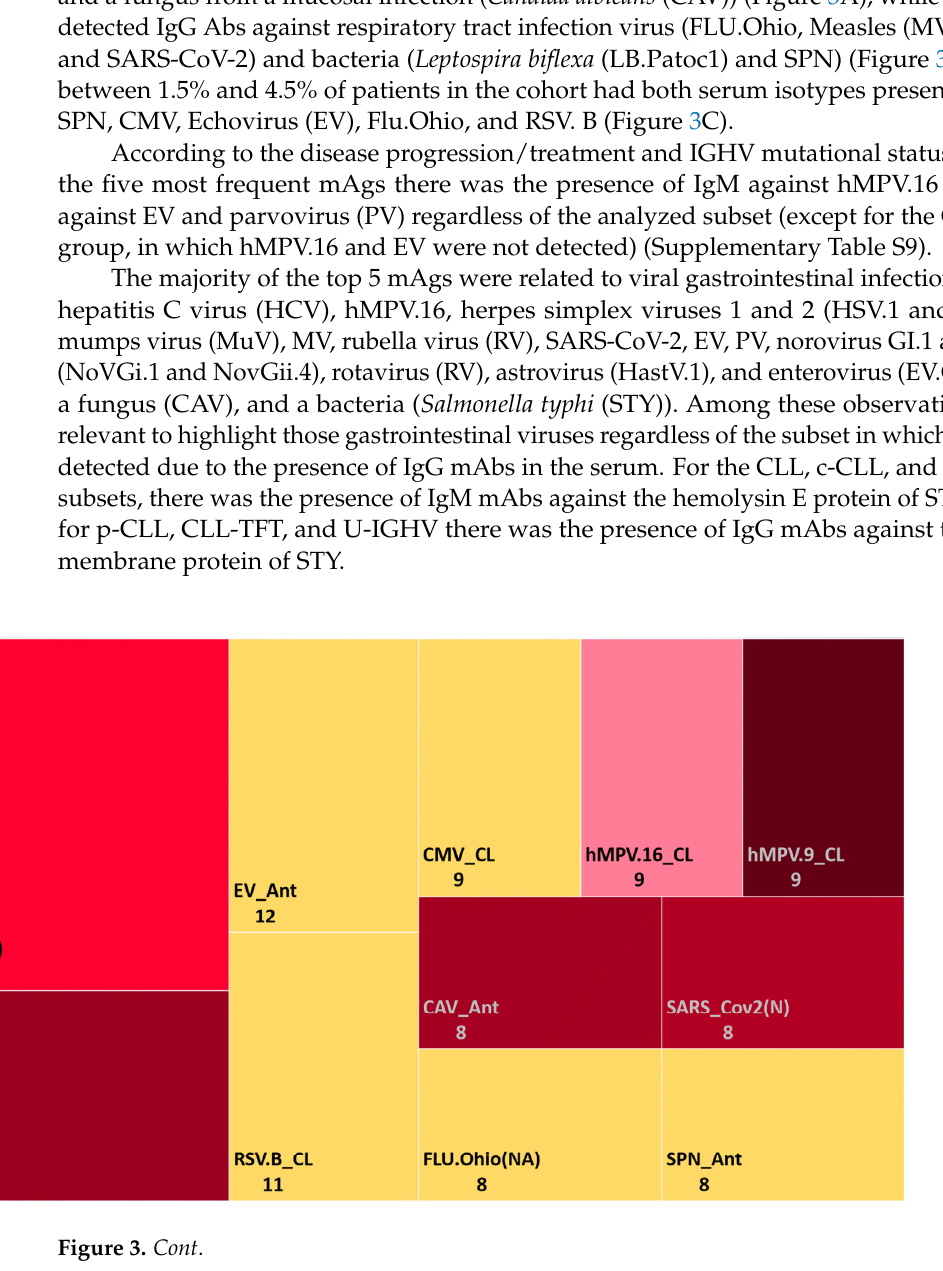
Figure 3. Quantitative summary of top 10 microbial antigens (mAgs) detected in this study: ( A ) mAgs detected by IgG antibodies (Abs) in the studied cohort; ( B ) mAgs detected by IgM Abs in the studied cohort; ( C ) number ( n #) and percentage (%) of samples for each detected mAg with respect to the total studied cohort.